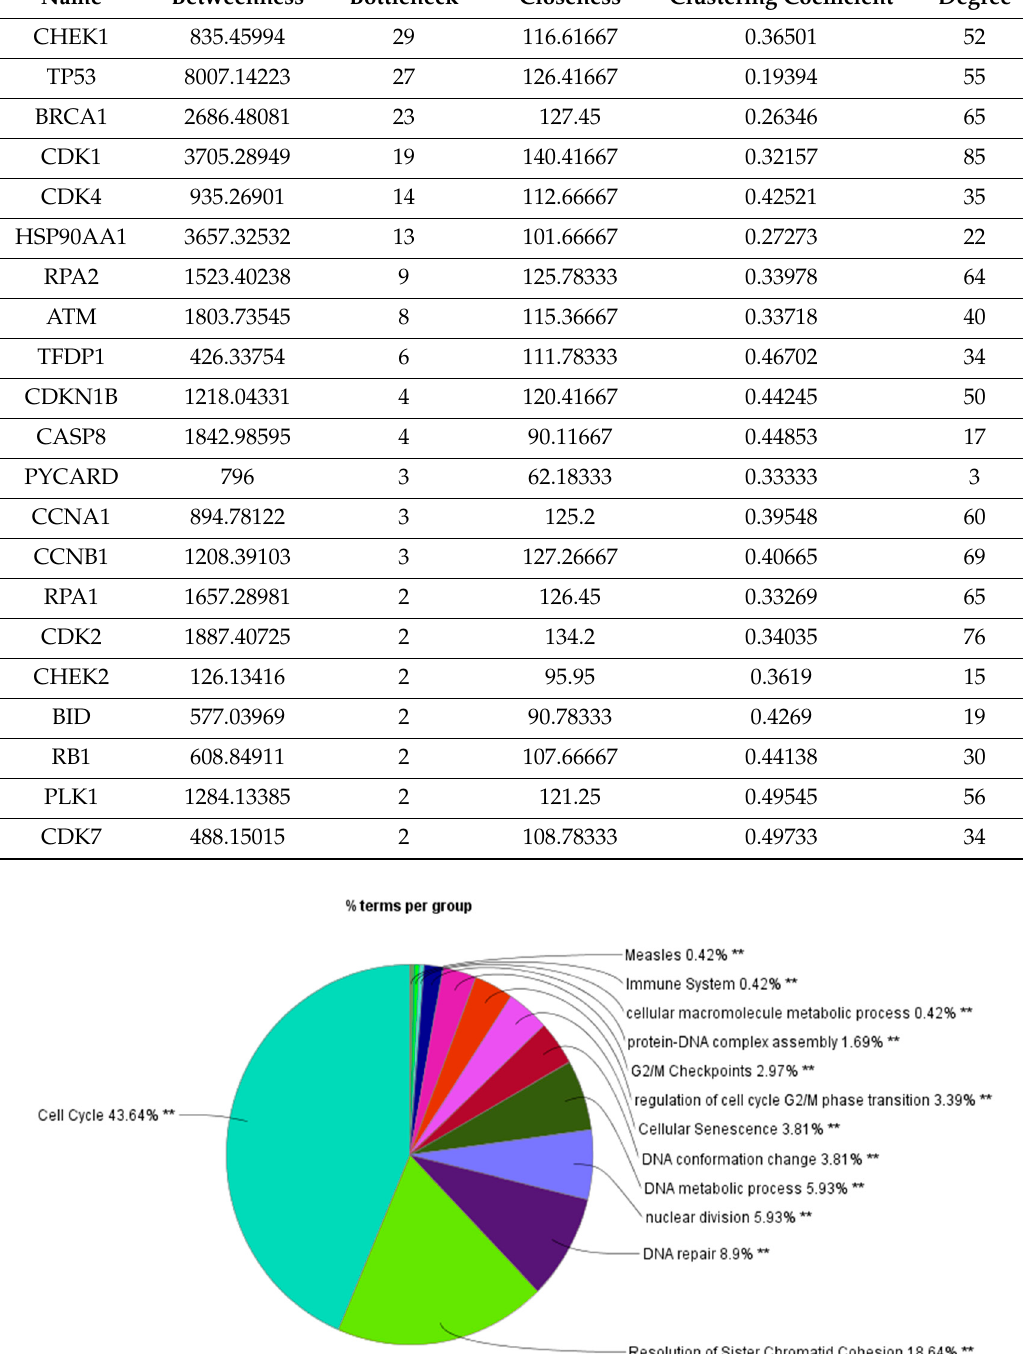
Table 2. Key proteins with their bottleneck, clustering coefficient, and degree scores.